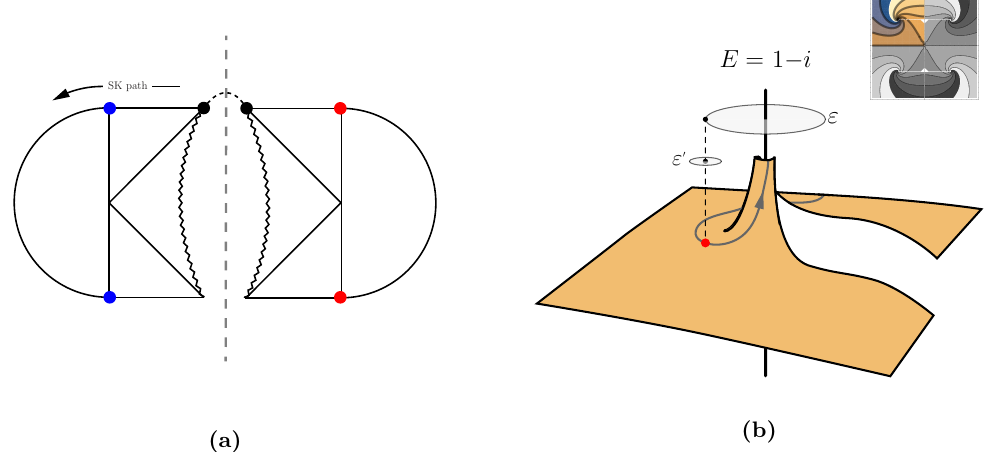
Figure 11. (a) We show the higher dimensional bulk dual to the SK path in figure 7(a). The bulk is quite similar to the BTZ one, but the singularities are necessarily bent inwards if the asymptotic boundary is to be kept a straight line. (b) The real part of (5.5) is presented in a countour plot in the upper right, and the colored piece, near E = 1 − i , is represented in 3D in the main part of the figure. The grey curve represents the path of the energy saddles as t (cid:29) t . At the red point, the c saddle is at a radius (cid:15) ∼ e − 4(1+ i ) t away from E = 1 − i . A second, smaller (cid:15) 0 (cid:28) (cid:15) deformation is also represented, that will be useful in our computation of F 2